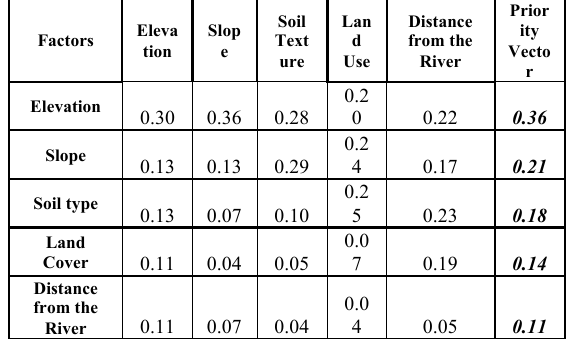
Table 2. Results of Analytic Hierarchy Process on the factors influencing flood susceptibility